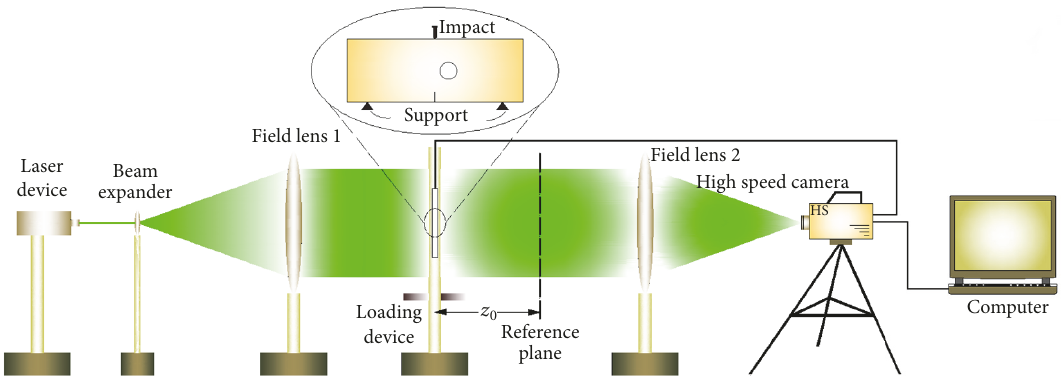
Figure 2: Beam path of the experimental system of digital laser dynamic caustics.